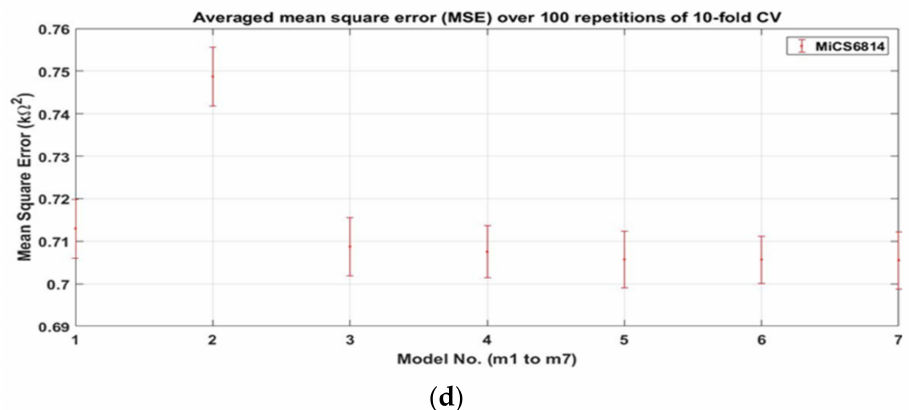
Figure 11. Averaged MSEs and standard deviation for all gas sensors using 10-fold CV with 100 repe- titions to find the optimal model selection from m1 to m7: ( a ) MiCS-5524, ( b ) GM-402, ( c ) GM-502B, and ( d )